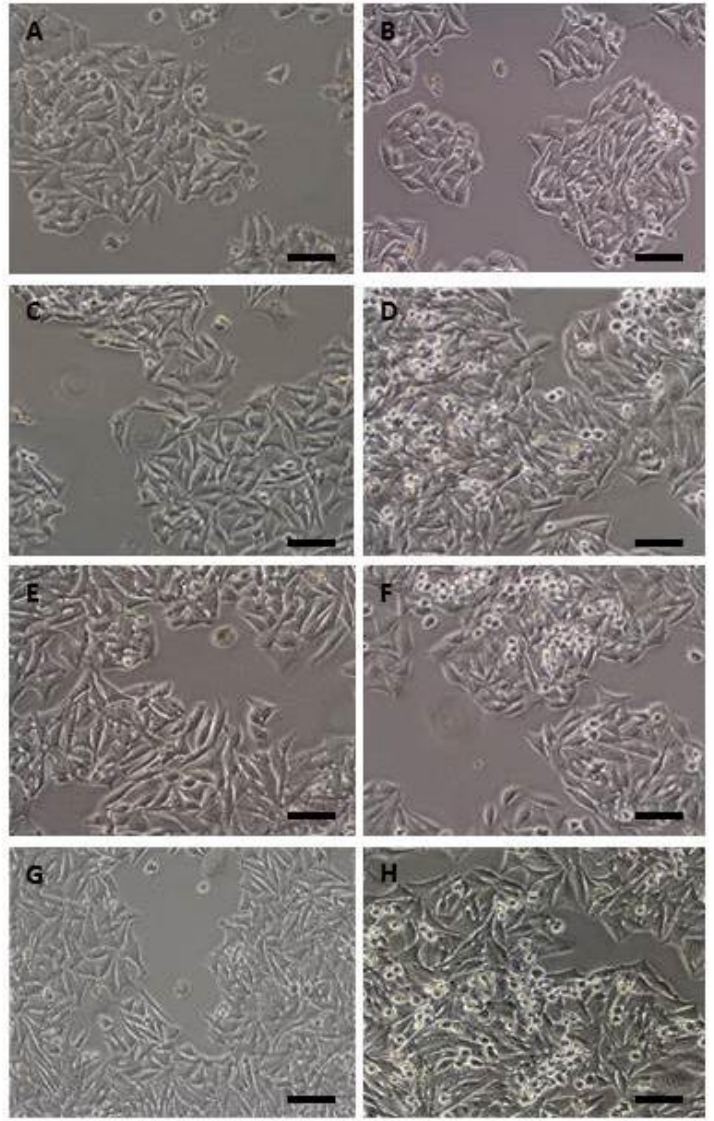
Figure 2. Phase contrast micrographs of parental DLD-1, DLD1/ Tet-On- gef , DLD1/ Tet-On- apoptin , and DLD1/ Tet-On- gef - apoptin cells after 48h of treatment with doxycycline (Scale bar = 100 µ m). No differences were observed between DLD1cells ( A ) and cells treated with Dox ( B ). However, the lines transduced with gef and/or apoptin and induced with Dox were characterized by the presence of a group of smaller, rounded cells (more evident in D, F, H), less adhered to the culture bottle when compared to the parental cells. ( C ) DLD1/Tet-On- apoptin not induced with Dox; ( D ) DLD1/Tet-On- apoptin induced with Dox; ( E ) DLD1/Tet-On- gef not induced with Dox; ( F ) Tet-On- gef induced with Dox; ( G ) DLD1/Tet-On- gef - apoptin not induced with Dox; ( H ) DLD1/Tet-On- gef - apoptin induced with Dox. Confocal and flow cytometry analysis confirmed these observations. After Annexin V and IP staining, and in comparison with control cells (Figure 4A,B), DLD1expressing gef or apoptin genes showed cells in early and late apoptosis (Figure 4C–F). However, DLD1/Tet-On- gef - apoptin cells were stained mainly as necrotic cells (Figure